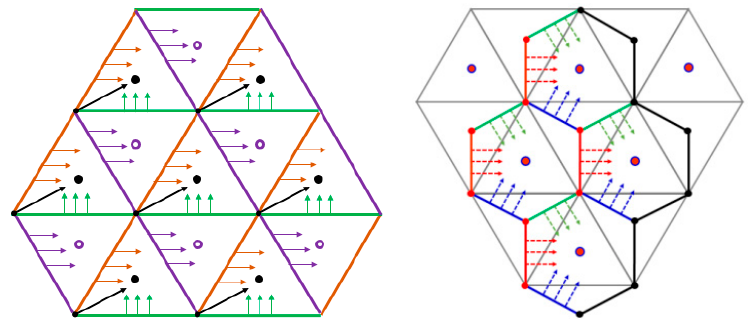
Figure 6. Rounding points of the plane to pixel midpoints ( left ) and to even midpoints ( right ). Let the borders of triangles take three di ff erent colors as in Figure 6 (left), purple (direction ‘ \ ’ with √ √ slope − 3), brown (direction ‘ / ’ with slope 3), and the green (horizontal) border lines. The next points are listing the cases where a point on the border could